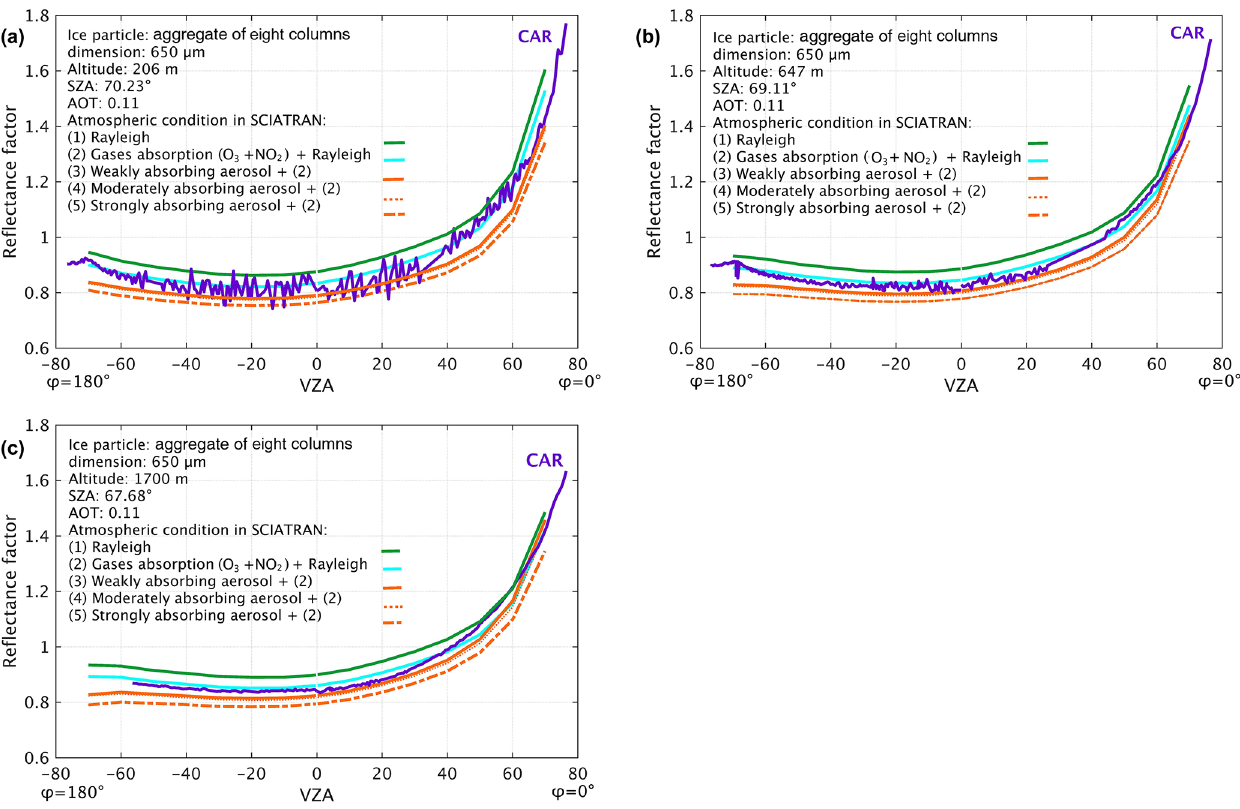
Figure 5. Measured and simulated reflectance factor at 0.677µm versus the viewing zenith angle (VZA) in the principal plane ( ϕ = 0 and 180 ◦ ) at three different flight altitudes. Panels represent results at 206, 647, and 1700m flight altitudes, respectively. The green lines indicate simulated reflectance assuming Rayleigh scattering (case i). The blue line shows reflectance for case ii (as in case i, including absorption of O 3 and NO 2 ). The orange lines show the reflectance for case iii (as in case ii but adding aerosol with an aerosol optical thickness (AOT)